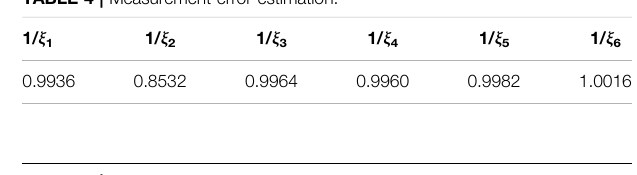
TABLE 5 | Comparison results. Least-squares method